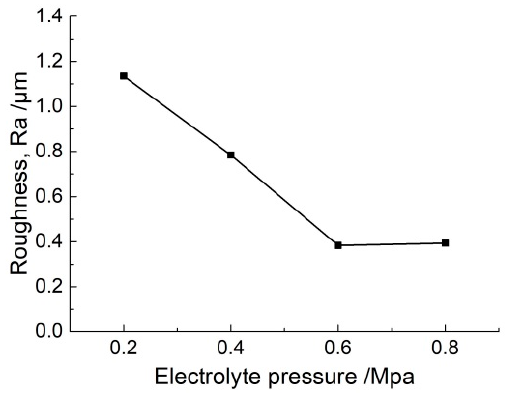
Figure 11. The roughness of micro-grooves generated with different electrolyte pressures ( U = 35 V, ε = 20%, f = 1 kHz, t on = 20 s).